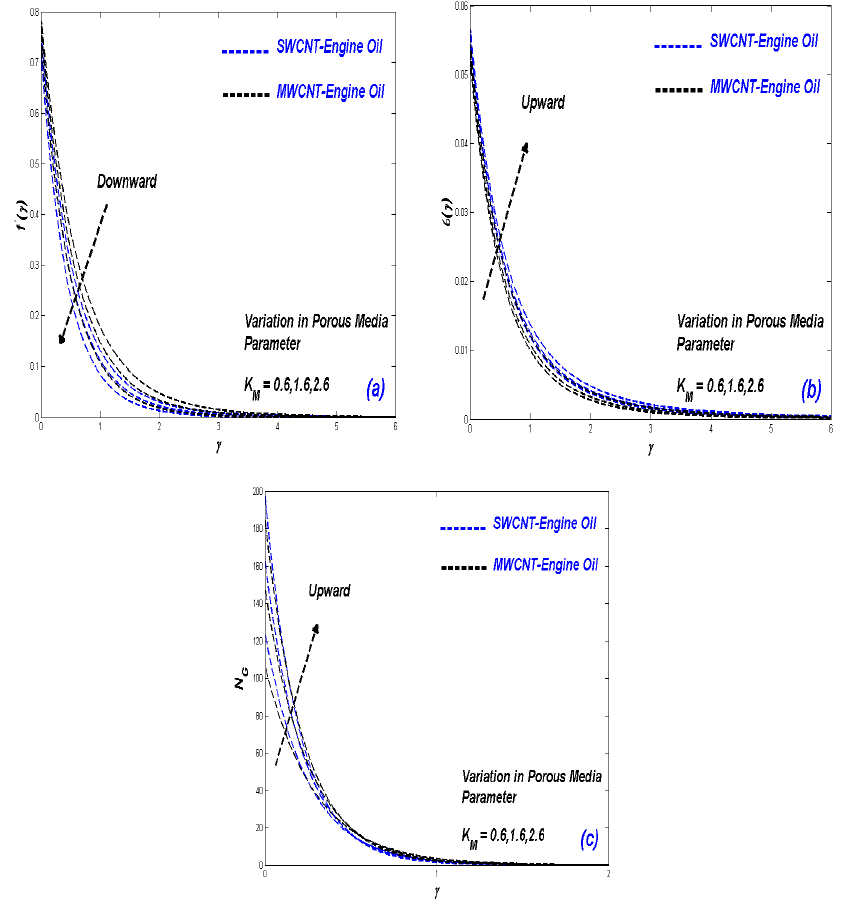
Figure 6. ( a ) Velocity change with 𝑘 (cid:3014) ; ( b ) Temperature change with 𝑘 (cid:3014) ; ( c ) Entropy change with 𝑘 (cid:3014)